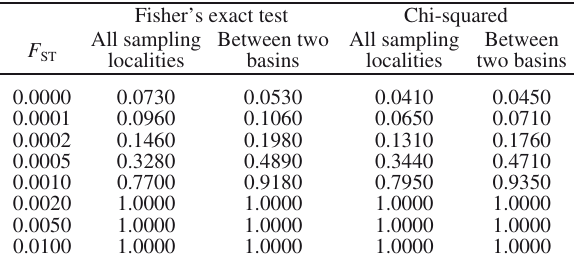
Table 5. – Results of POWSIM